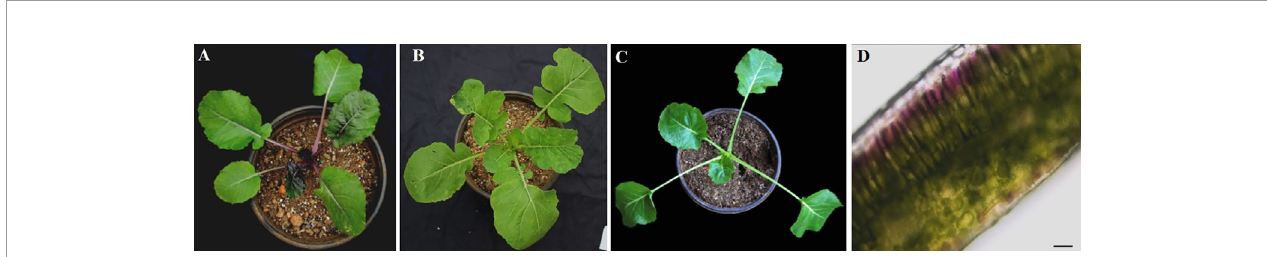
FIGURE 1 | Characterization of anthocyanin accumulation in leaves of purple rapeseed. (A – C) Different phenotype of young plant of PR (A) and ZS11 (B) planted outdoor and PR in the glass greenhouse (C) . (D) Hand section of a young leaf of PR. Scale bar: 10 m m.